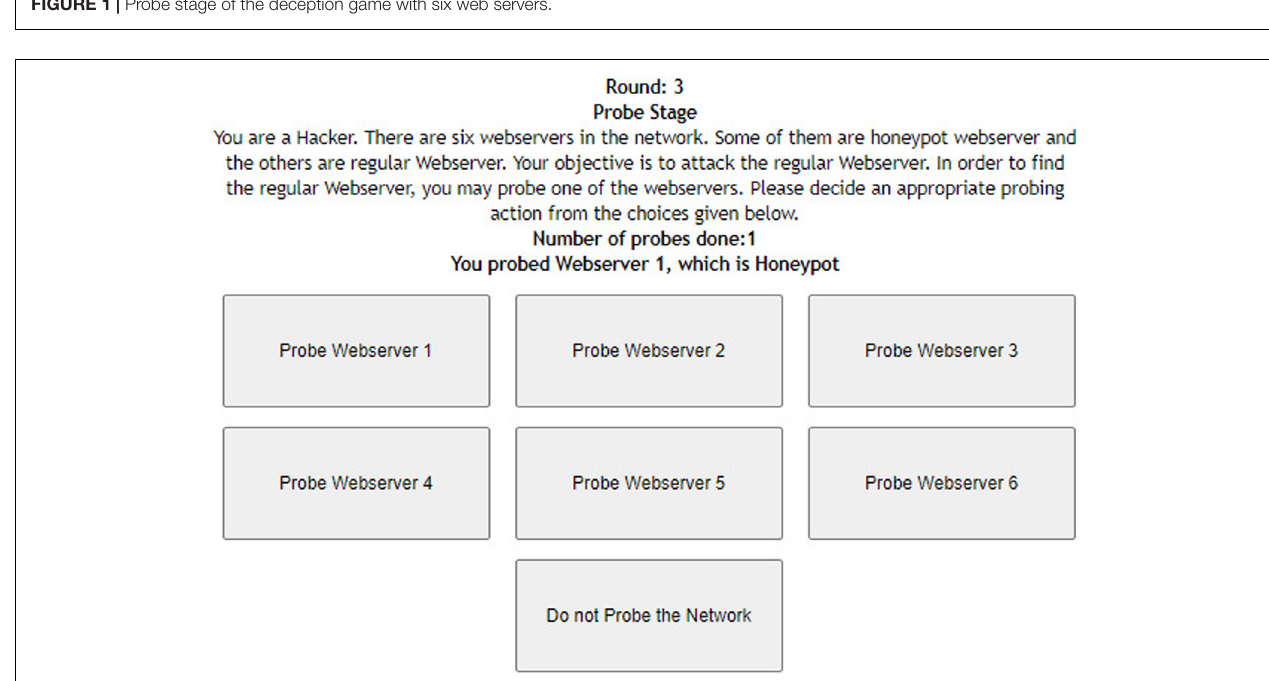
FIGURE 2 | Probe stage of the deception game with six web servers after the participant probes for the first